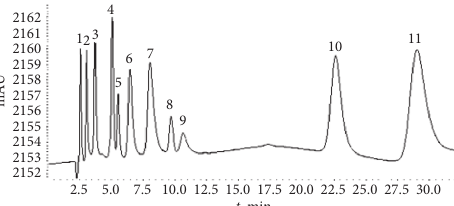
Figure 9: Separation of PA and nitrogen-containing compounds on the SP-2 column (150 × 4.6mm). Compounds (0.32–15 μ g/ml): 1, nadolol; 2, tetrahydrozoline; 3, atenolol; 4, sorbic acid; 5, benzoic acid; 6, carbinoxamine; 7, chlorpheniramine; 8, vanillic acid; 9, gallic acid; 10, sinapic acid; 11, caffeic